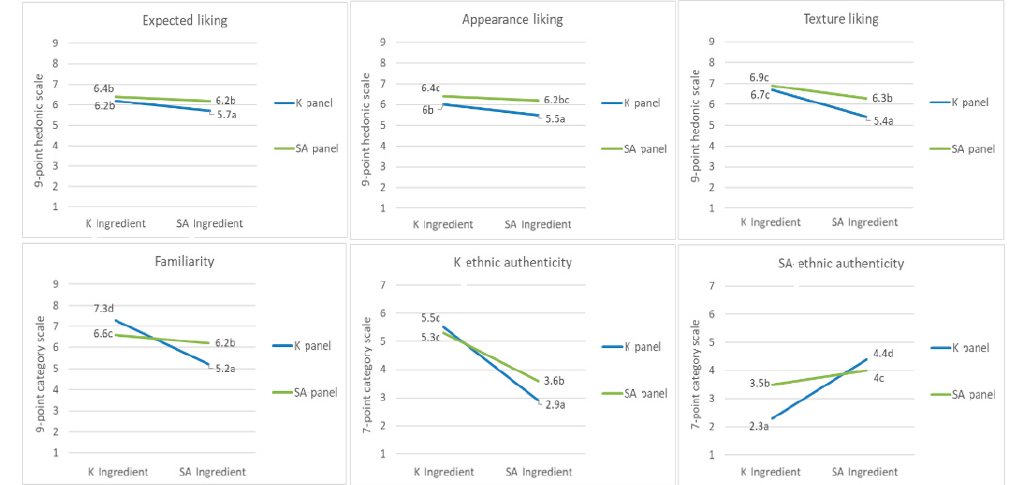
Figure 1. Effect of the nationality of the panel × ingredient on the expected liking, appearance liking, texture liking, familiarity, and K and SA ethnic authenticity, di ff erent letters indicate